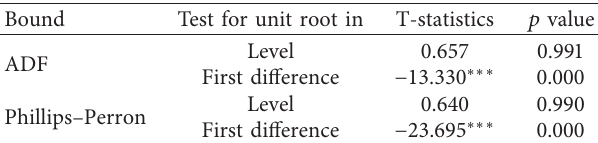
Table 2: Augmented Dickey–Fuller (ADF) test results on the house price series.